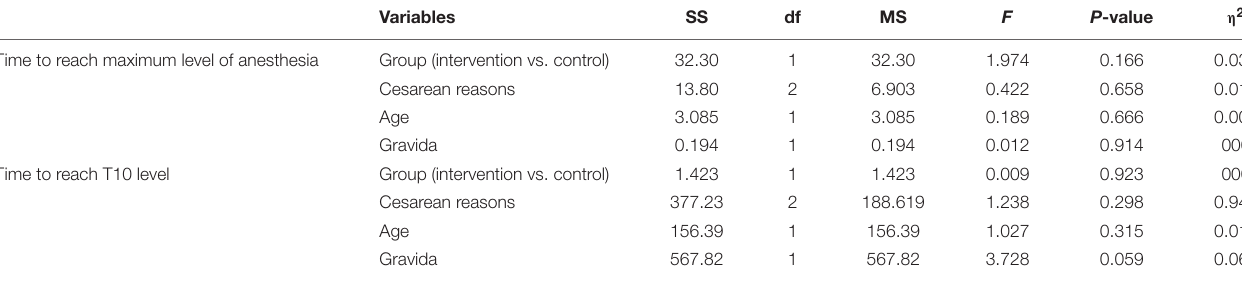
TABLE 3 | Univariate effect of collected variables on time to reach maximum level of anesthesia and time reach T10 level.